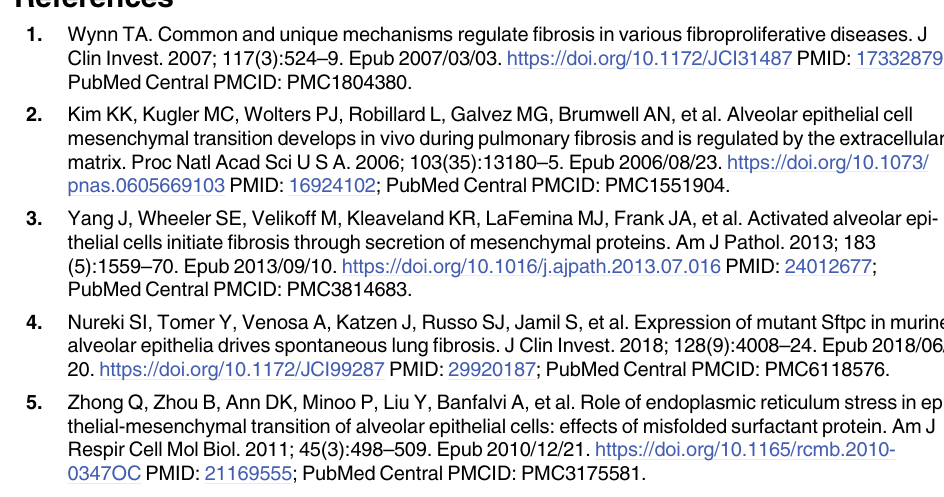
S2 Fig. Raw western blot